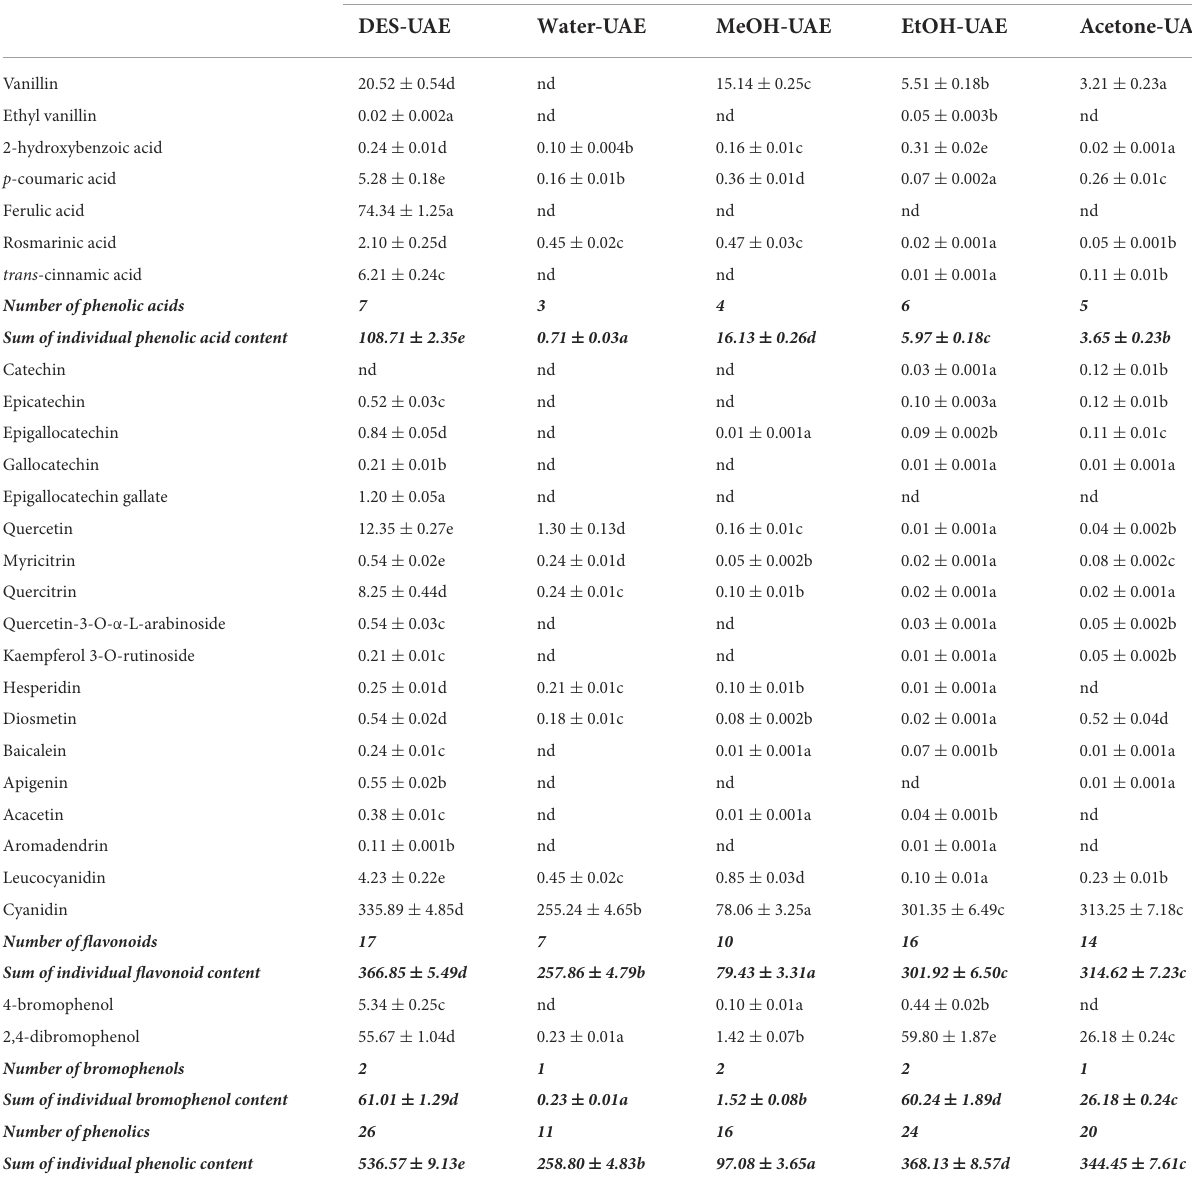
TABLE 5 Quantification of individual phenolic compounds from Asparagopsis taxiformis by